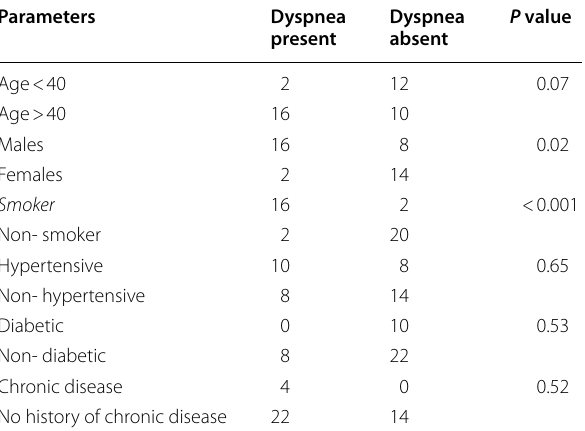
Table 2 Association of dyspnea with patients age, sex, and coexisting illnesses